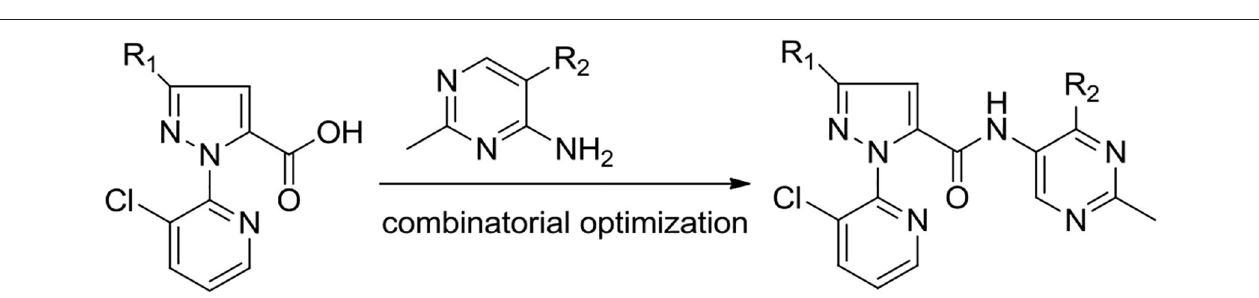
FIGURE 2 | Structures of chlorantraniliprole and cyantraniliprole.